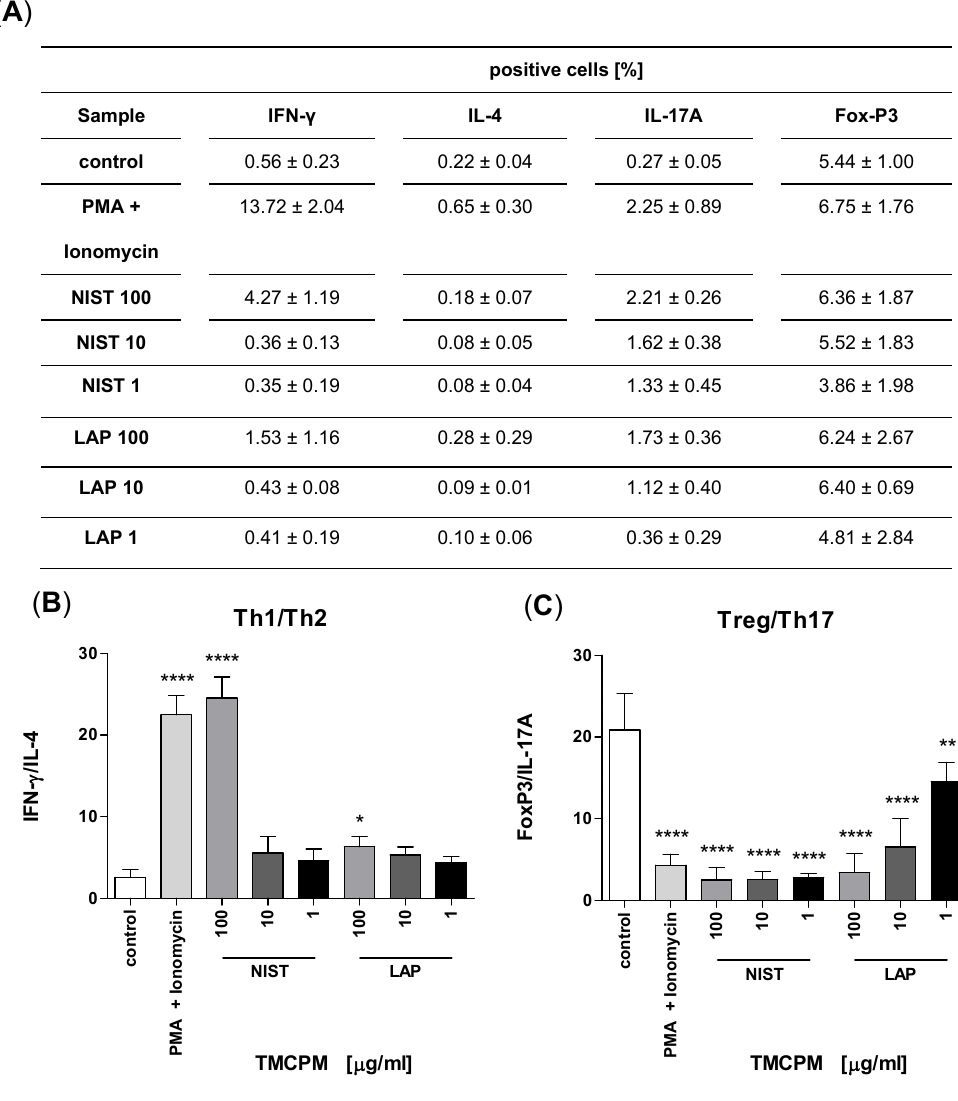
Figure 3. E ff ect of PBMC exposition to TMCPM (NIST and LAP) on the ratio of Th1 / Th2 and Treg / Th17 T cells. PBMC were stimulated as described in Materials and methods and percentage of Th1, Th2, Th17, and Treg cells was quantified as the frequency of cells positive for IFN- γ , IL-4, IL-17A, and FoxP3, respectively ( A ). The ratio of the frequency (%) of IFN- γ positive to IL-4 positive CD4 + T cells (Th1 / Th2) ( B ) and FoxP3 positive to IL-17A positive CD4 + T cells (Treg / Th17) ( C ) was calculated. Data are presented as mean ± SEM from twelve independent experiments. Di ff erences between the groups were considered statistically significant at the following p values: * p < 0.1, ** p < 0.01, **** p <